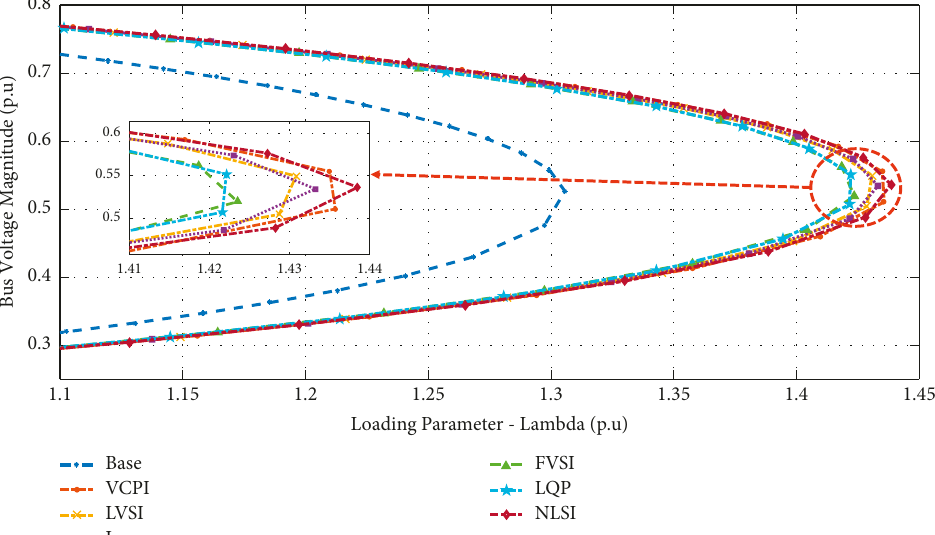
Figure 13: Maximum loadability in SC-1 by PV curves at Bus 30.